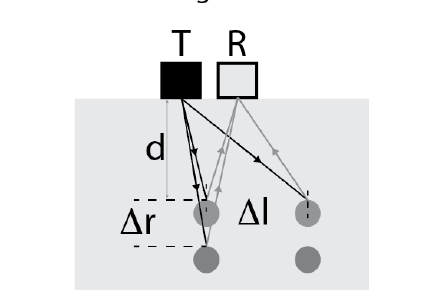
Figure 9. The GPR resolution can be divided into two parts: The lateral ( ∆ l) and the longitudinal resolution ( ∆ r).